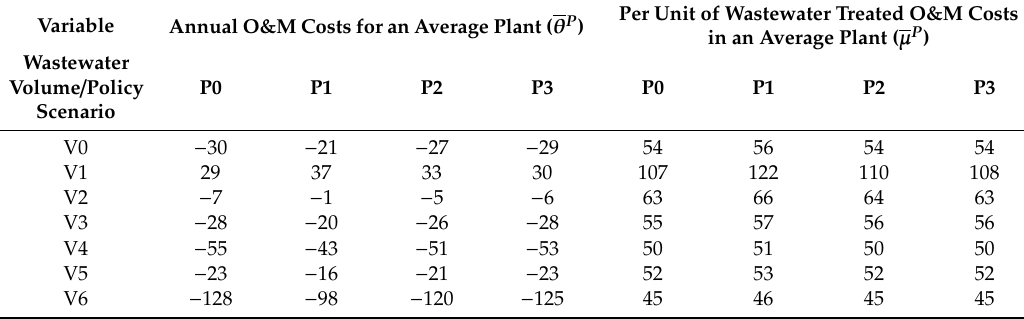
Table 9. Ratio of di ff erences in calculated annual operating and maintenance costs between simulations by volume and policy